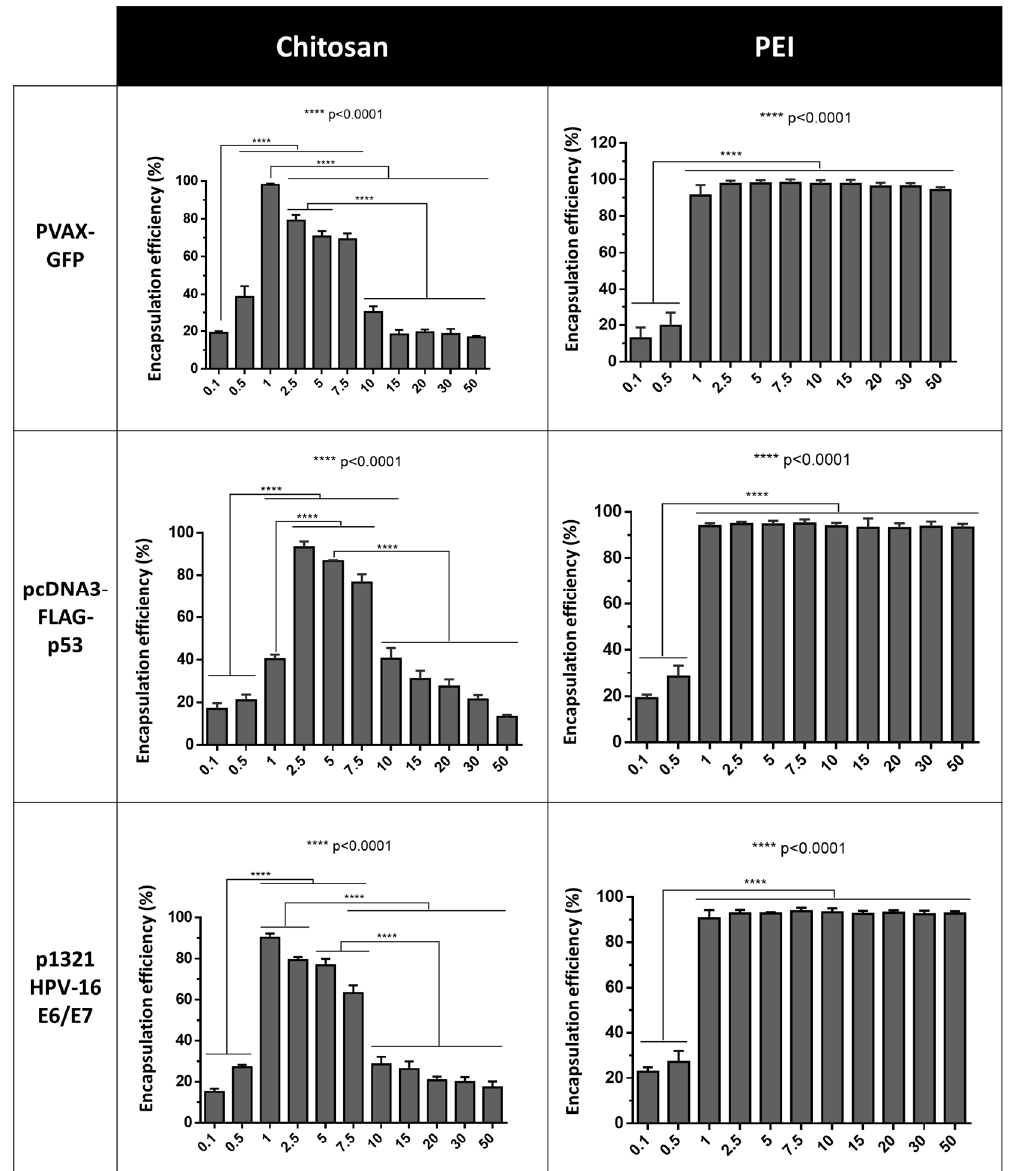
Figure 1. Encapsulation efficiency obtained for each formulation. A. CH-based nanocarriers; B. PEI-based nanocarriers. The asterisks indicate a statistically significant increase in the E.E. of the polyplexes produced with the different polymer ratio under study. Data are presented as mean ± S.D., n = 3.